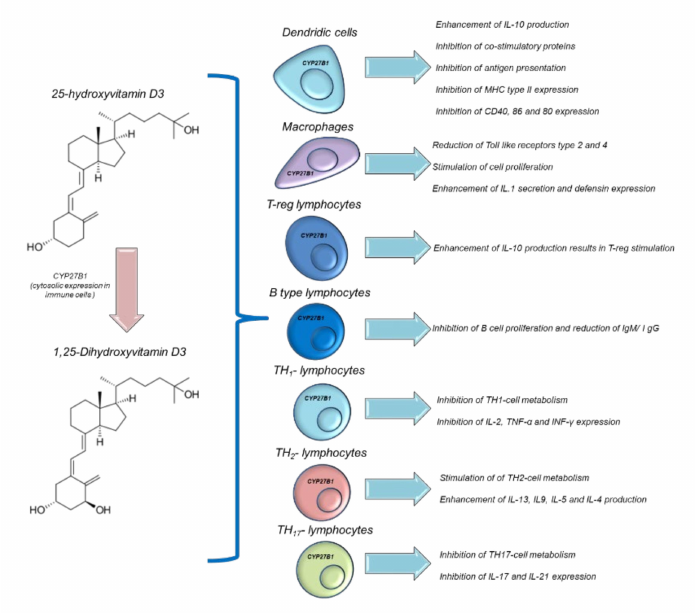
Figure 5. Immune modulation of Vitamin D in different immune